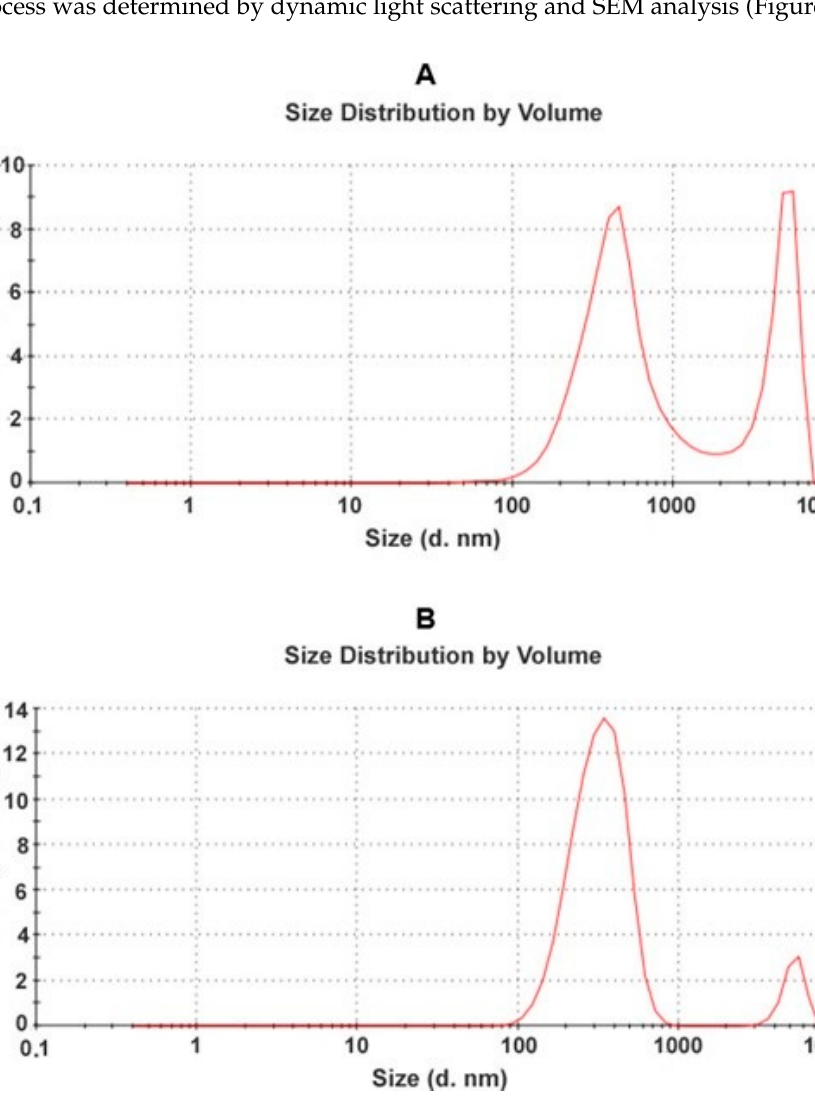
Figure 1. Carbon particle size distribution according to dynamic light scattering data: ( A ) after grinding AX-21 with a ball mill (fraction C1); ( B ) after 40 min of grinding C1 with a bead mill (fraction CW2).